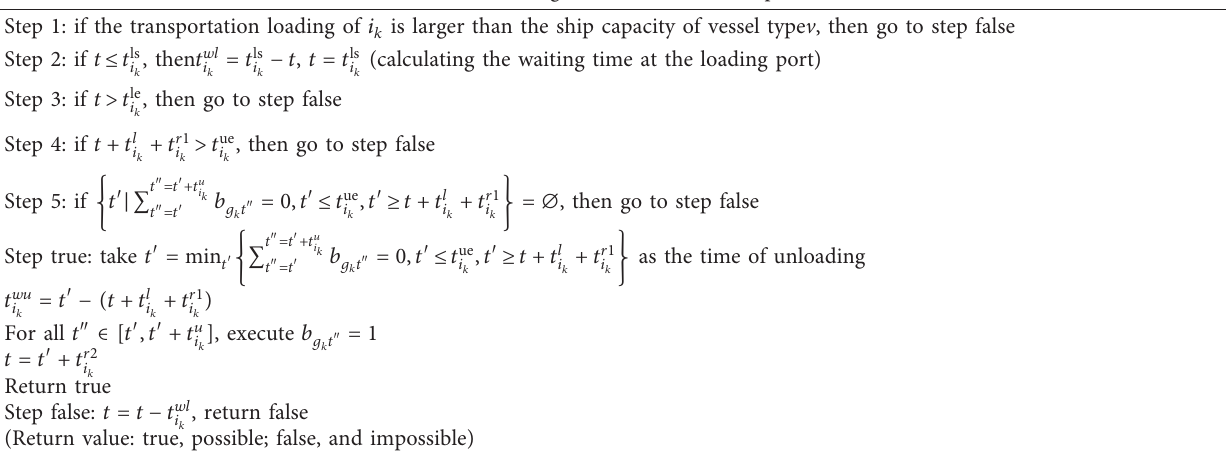
Table 5: Procedure for determining whether vessel v can process mission i at time t